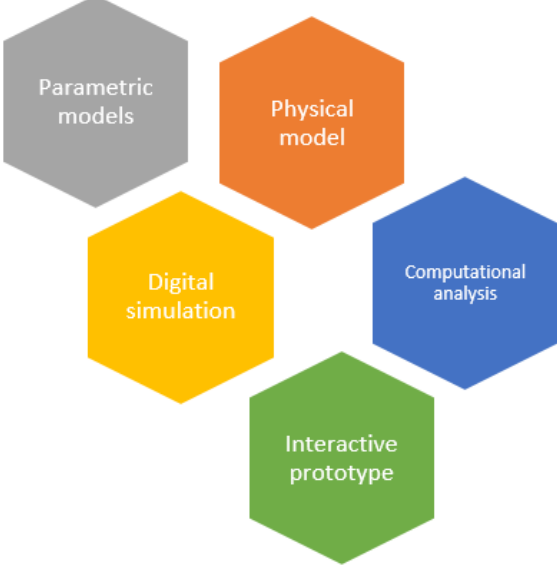
Figure 11. Various means that explore the six design aspects of the framework (source: